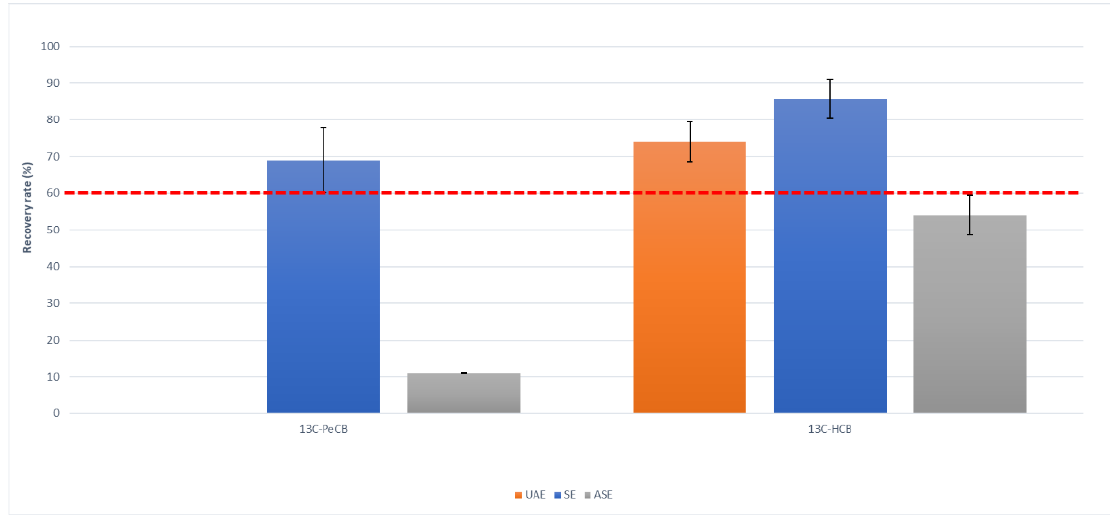
Figure 3. Recovery rates (%) and standard deviation of 13 C-PeCB and 13 C-HCB by ultrasonic assisted (UAE), Soxhlet (SE) and accelerated solvent (ASE) extraction. Each procedure was performed in triplicate.